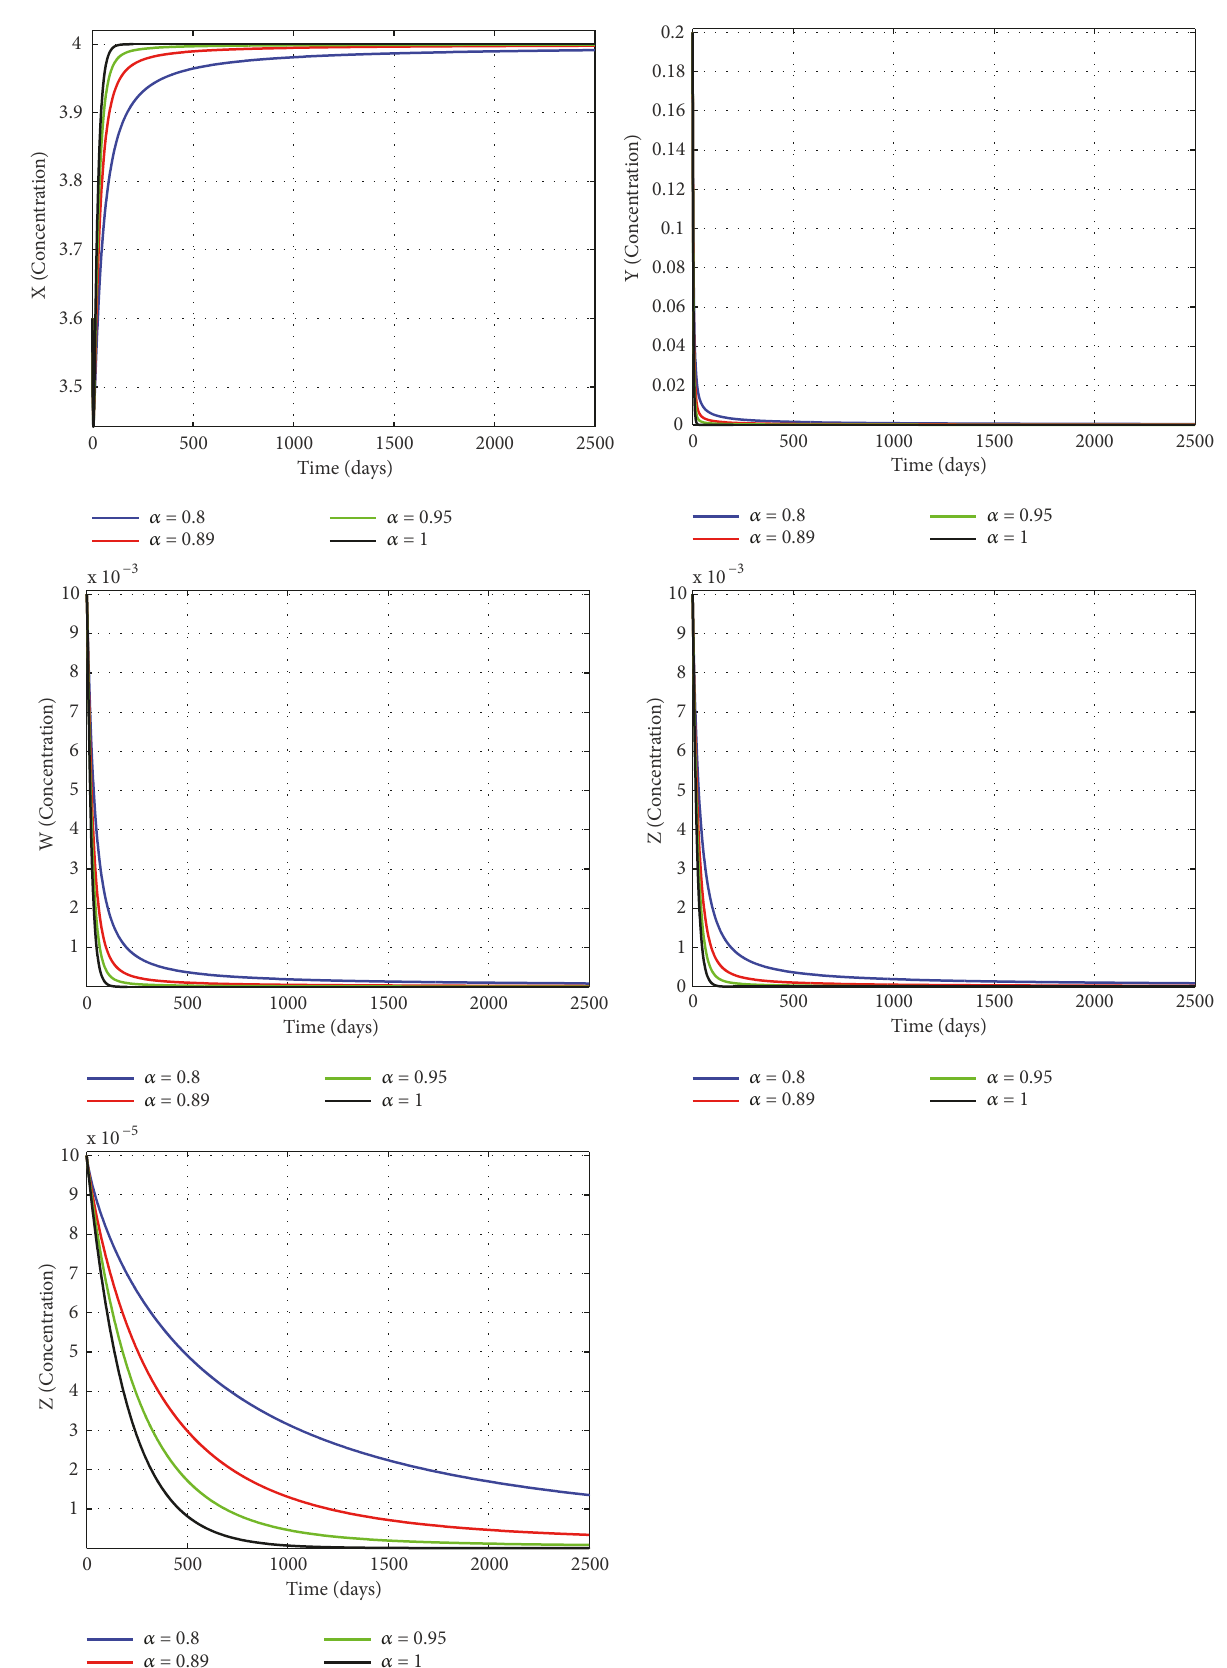
Figure 2: The dynamics of mathematical model of HSCs gene-based therapy for free virus